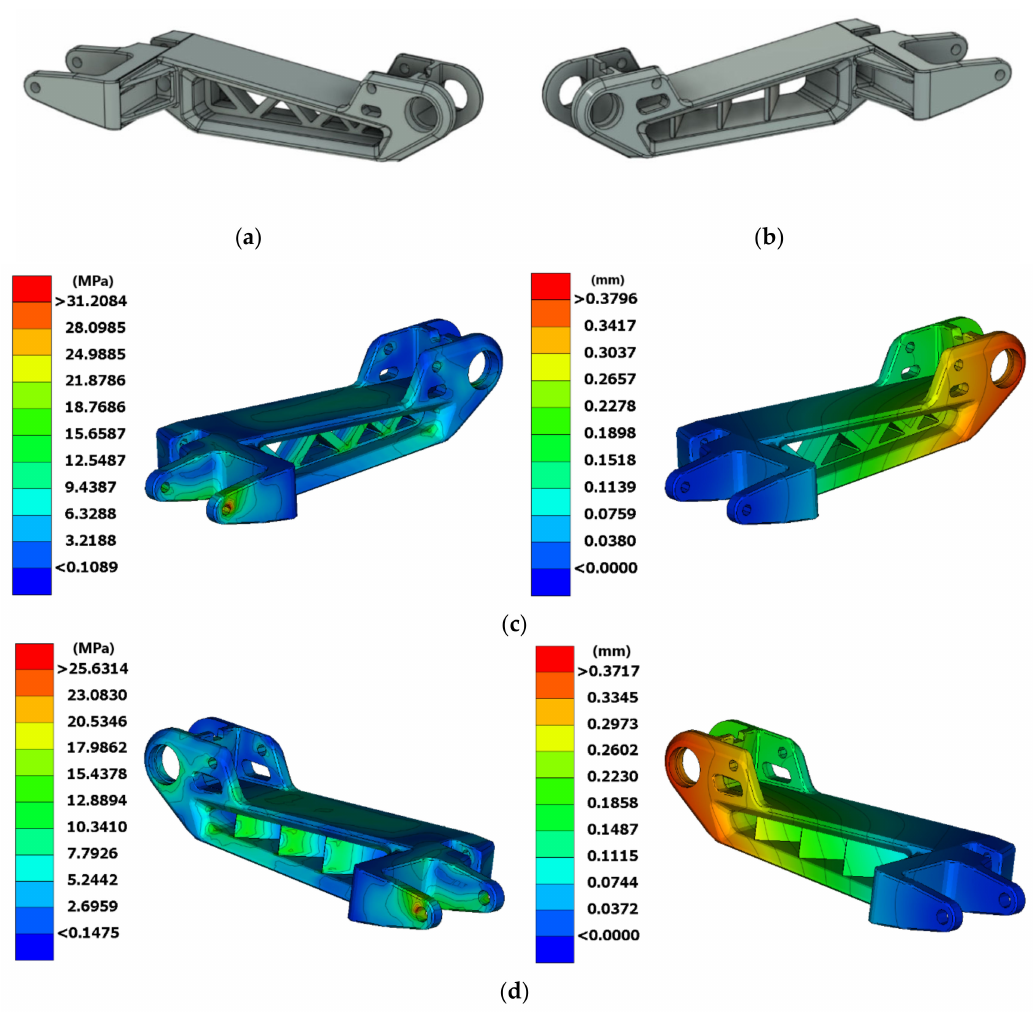
Figure 12. Di ff erent swingarm versions and results: ( a ) 1st alternative swingarm design; ( b ) 2nd alternative swingarm design; ( c ) results of stresses and displacements for 1st alternative swingarm; ( d ) results of stresses and displacements for 2nd alternative swingarm.